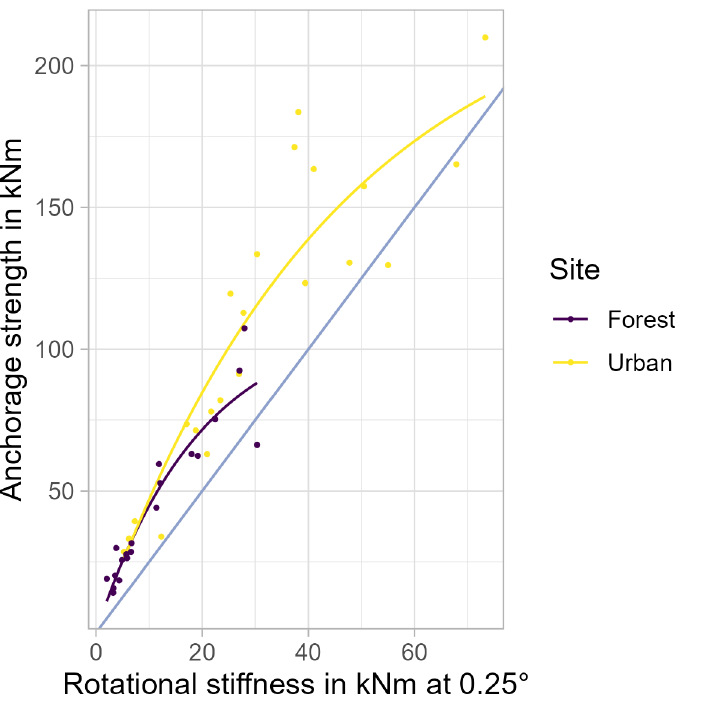
Figure 9. Rotational stiffness and maximum bending moments of B. pendula in forests and urban sites. There is no difference between anchorage and the ratio of the two parameters (Table A4). The blue line indicates a slope of 2.5 [34]. Fitted lines: M a = a ( 1 − e − e b k r )